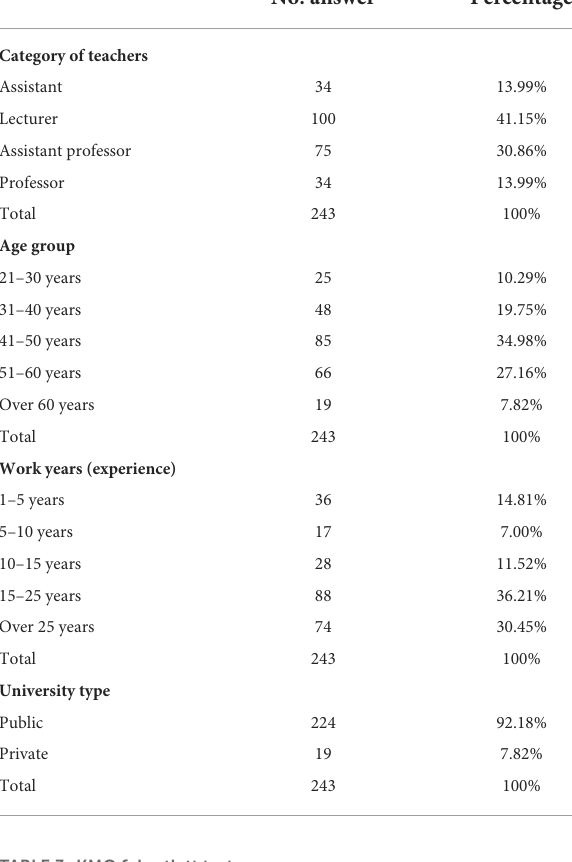
TABLE 3 KMO & bartlett test.